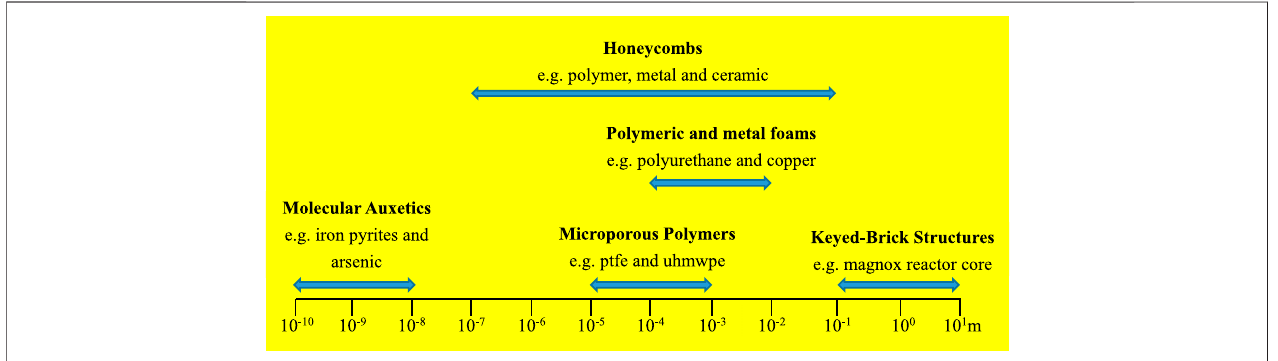
FIGURE 2 | Different scale materials with negative Poisson ’ s